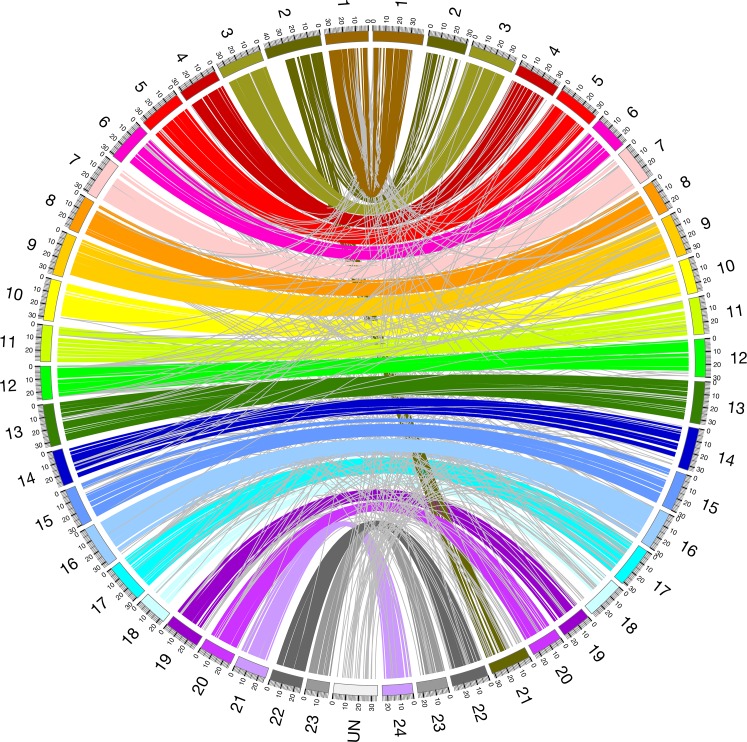
Whole genome alignment between Guppy and Medaka.Circos plot of syntenic relationship between guppy (left) and medaka (right) chromosomes. Minimum block length 500 bp. Light grey lines indicate non-syntenic alignment blocks or blocks not assigned to any guppy linkage group (UN).